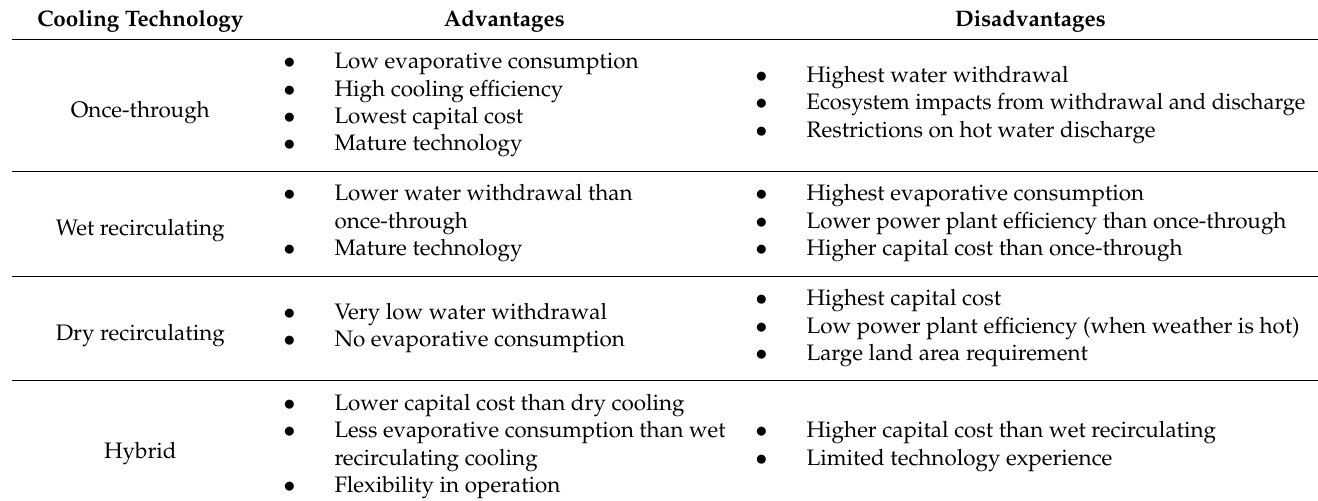
Table 2. Thermal power plants can use various types of cooling systems, which each have advantages and disadvantages in terms of water withdrawal, water consumption, cost, generation efficiency, and other